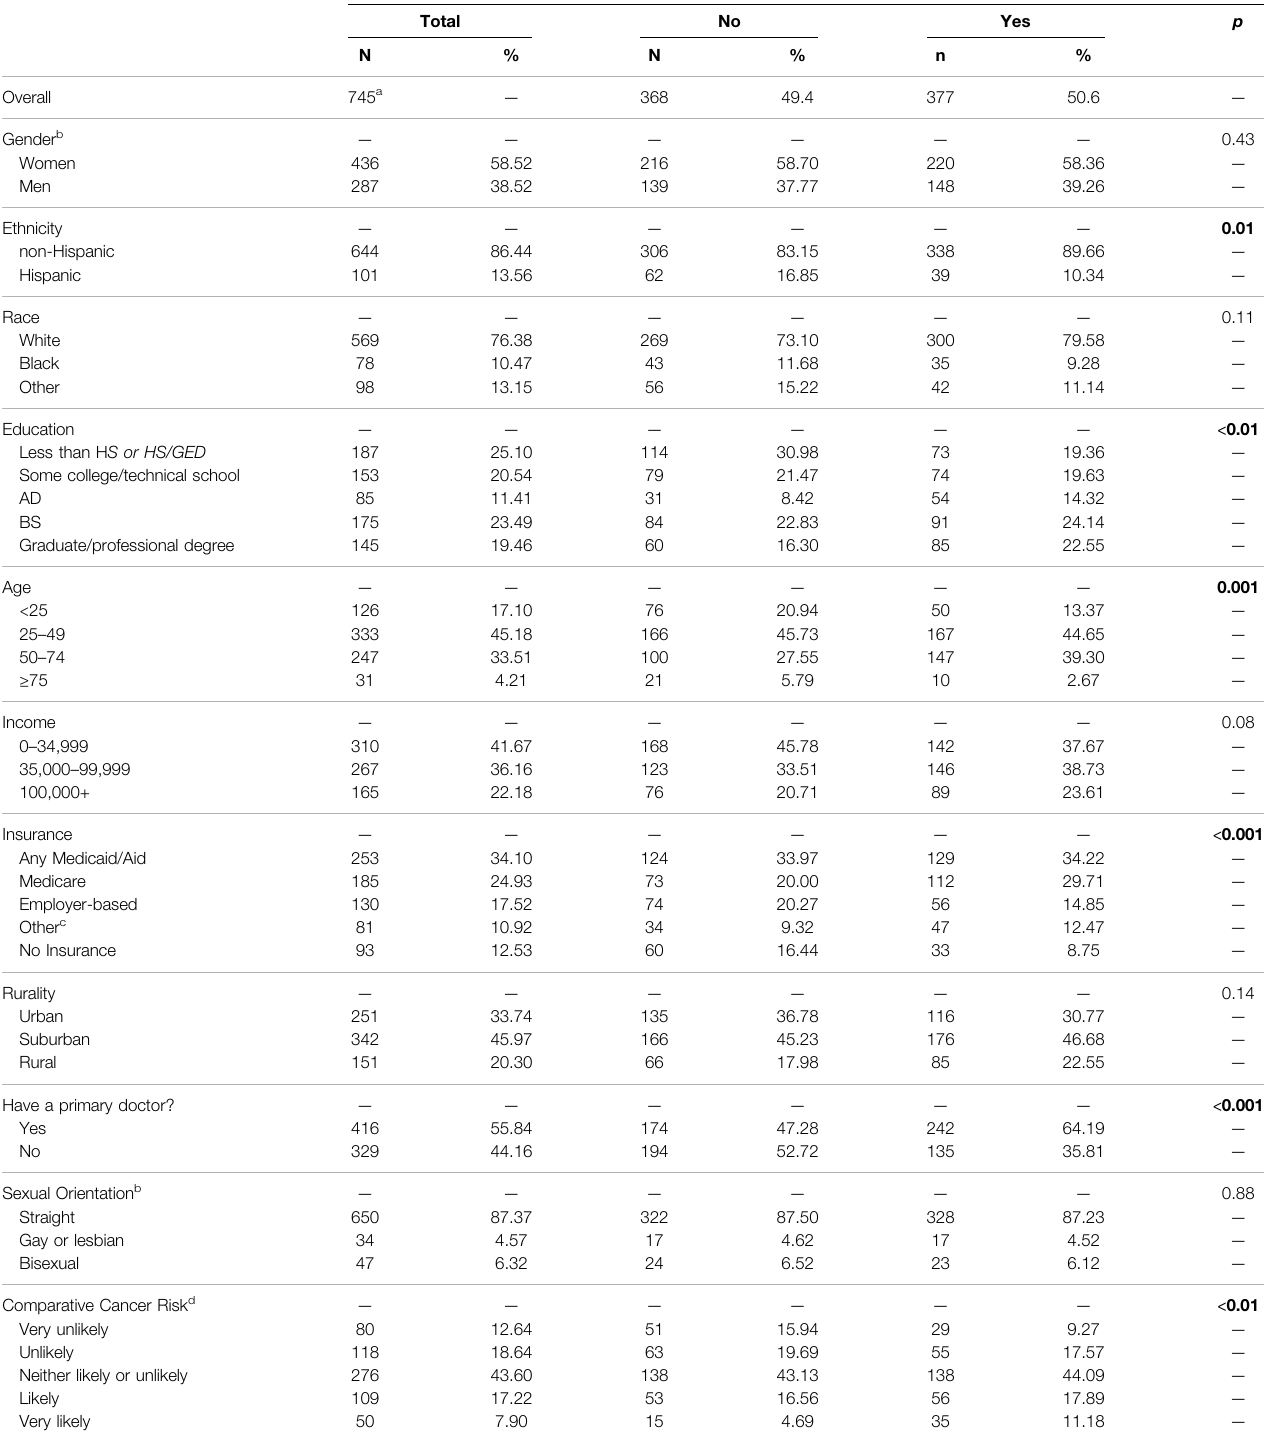
TABLE 1 | Overall descriptive statistics and by awareness about genetic tests.